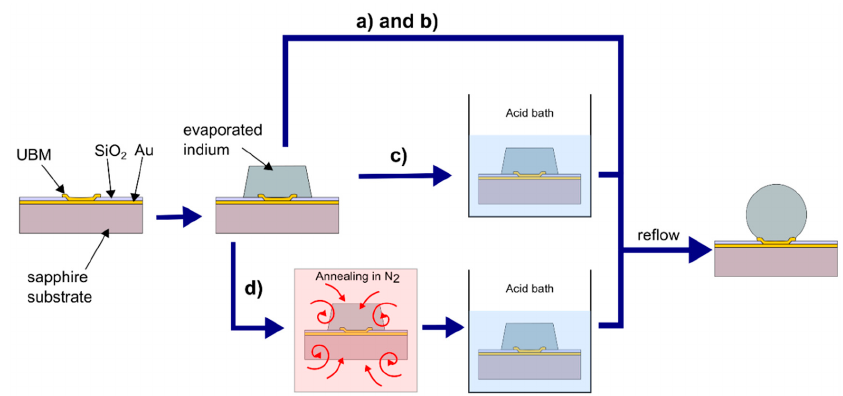
Figure 2. The schematic diagram of the indium bump formation process showing three alternative approaches. ( a ) reflow in the hydrochloric acid vapors without pre-etching of In columns; ( b ) reflow in the formic acid vapors without pre-etching of In columns; ( c ) reflow in the formic acid vapors with wet pre-etching of In columns in formic or hydrochloric acid solution; ( d ) reflow in the formic acid vapors with annealing preceding the wet pre-etching of In columns in hydrochloric acid solution.